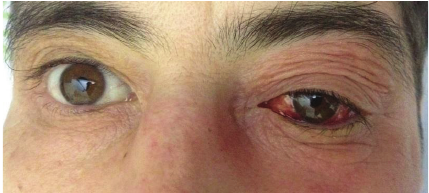
Figure 2: Pelvic CT demonstrating enlarged lymph nodes in the pelvis, more pronounced in the left iliac region.